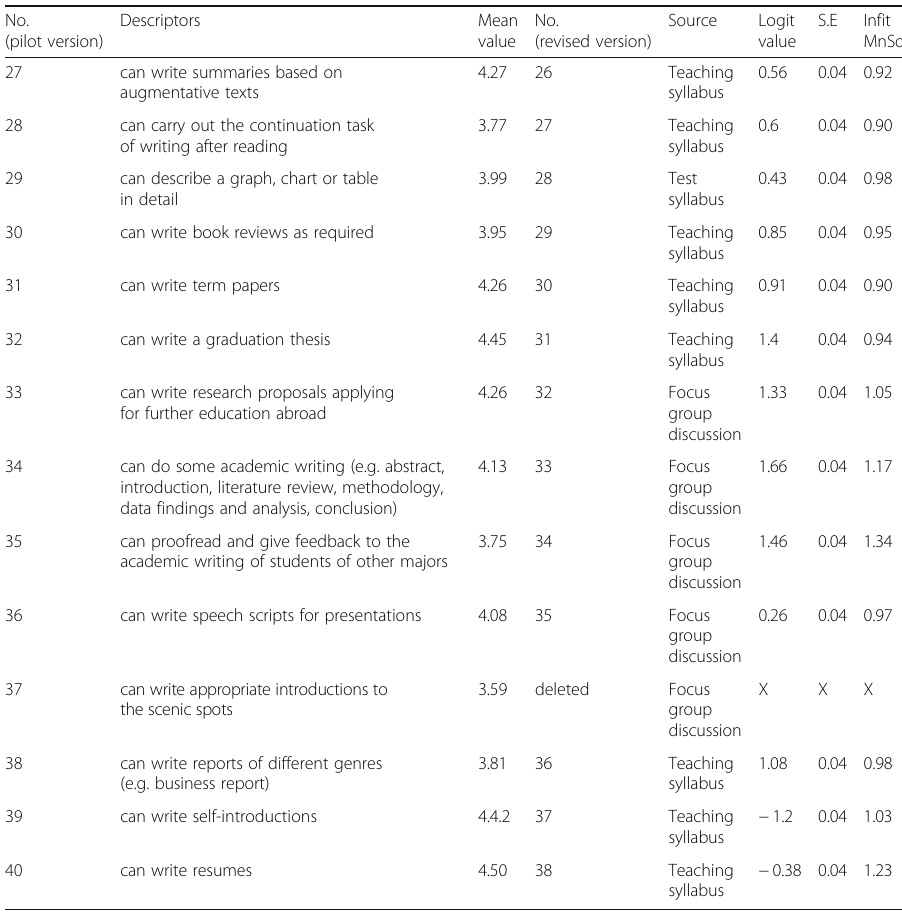
Table 2 Mean value, source, logit value, S.E., and Infit MnSq. of the descriptors (pilot version and revised version)